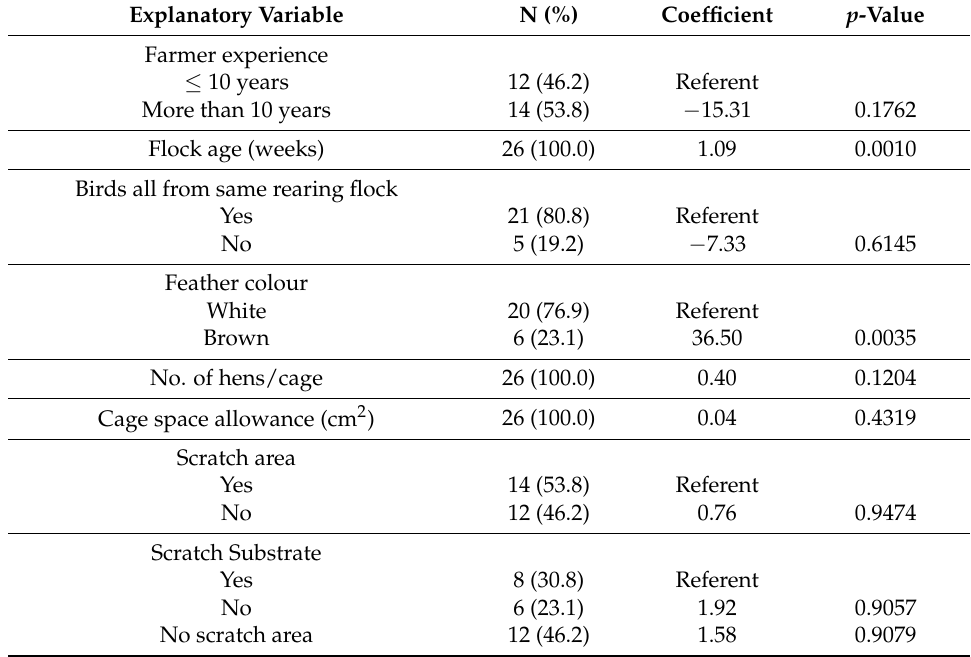
Table 4. Housing and management factors ( p ≤ 0.25) associated with the presence of feather damage in furnished cage laying flocks at the univariable analysis